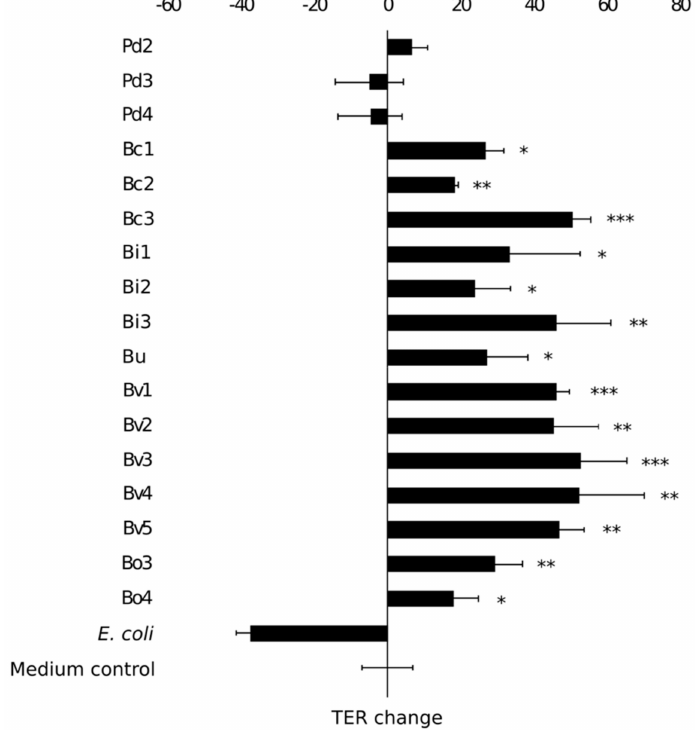
Figure 5. The e ff ect of isolates on transepithelial electrical resistance (TER) of Caco-2 monolayer. E. coli was used as a negative control. Results are shown as the mean of TER value change ( Ω / cm 2 ) in 24 hours and standard deviation of three technical replicates (parallel wells). An asterisk indicates significantly di ff erent ( p < 0.05) value as compared to the untreated Caco-2 monolayers (medium control). * p < 0.05, ** p < 0.01, *** p < 0.001. Pd = P. distasonis , Bc = B. caccae , Bi = B. intestinalis , Bu = B. uniformis , Bv